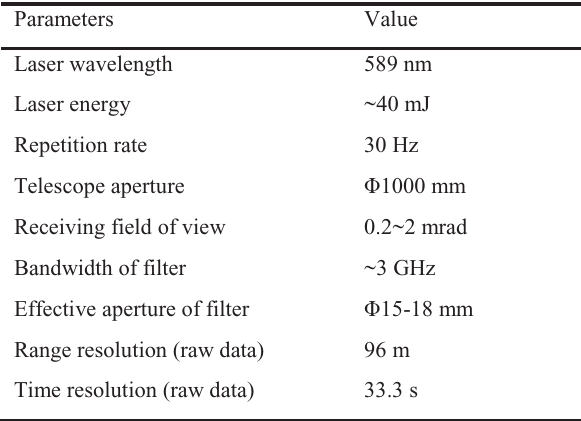
Table 1. The main parameters of broadband Na lidar in